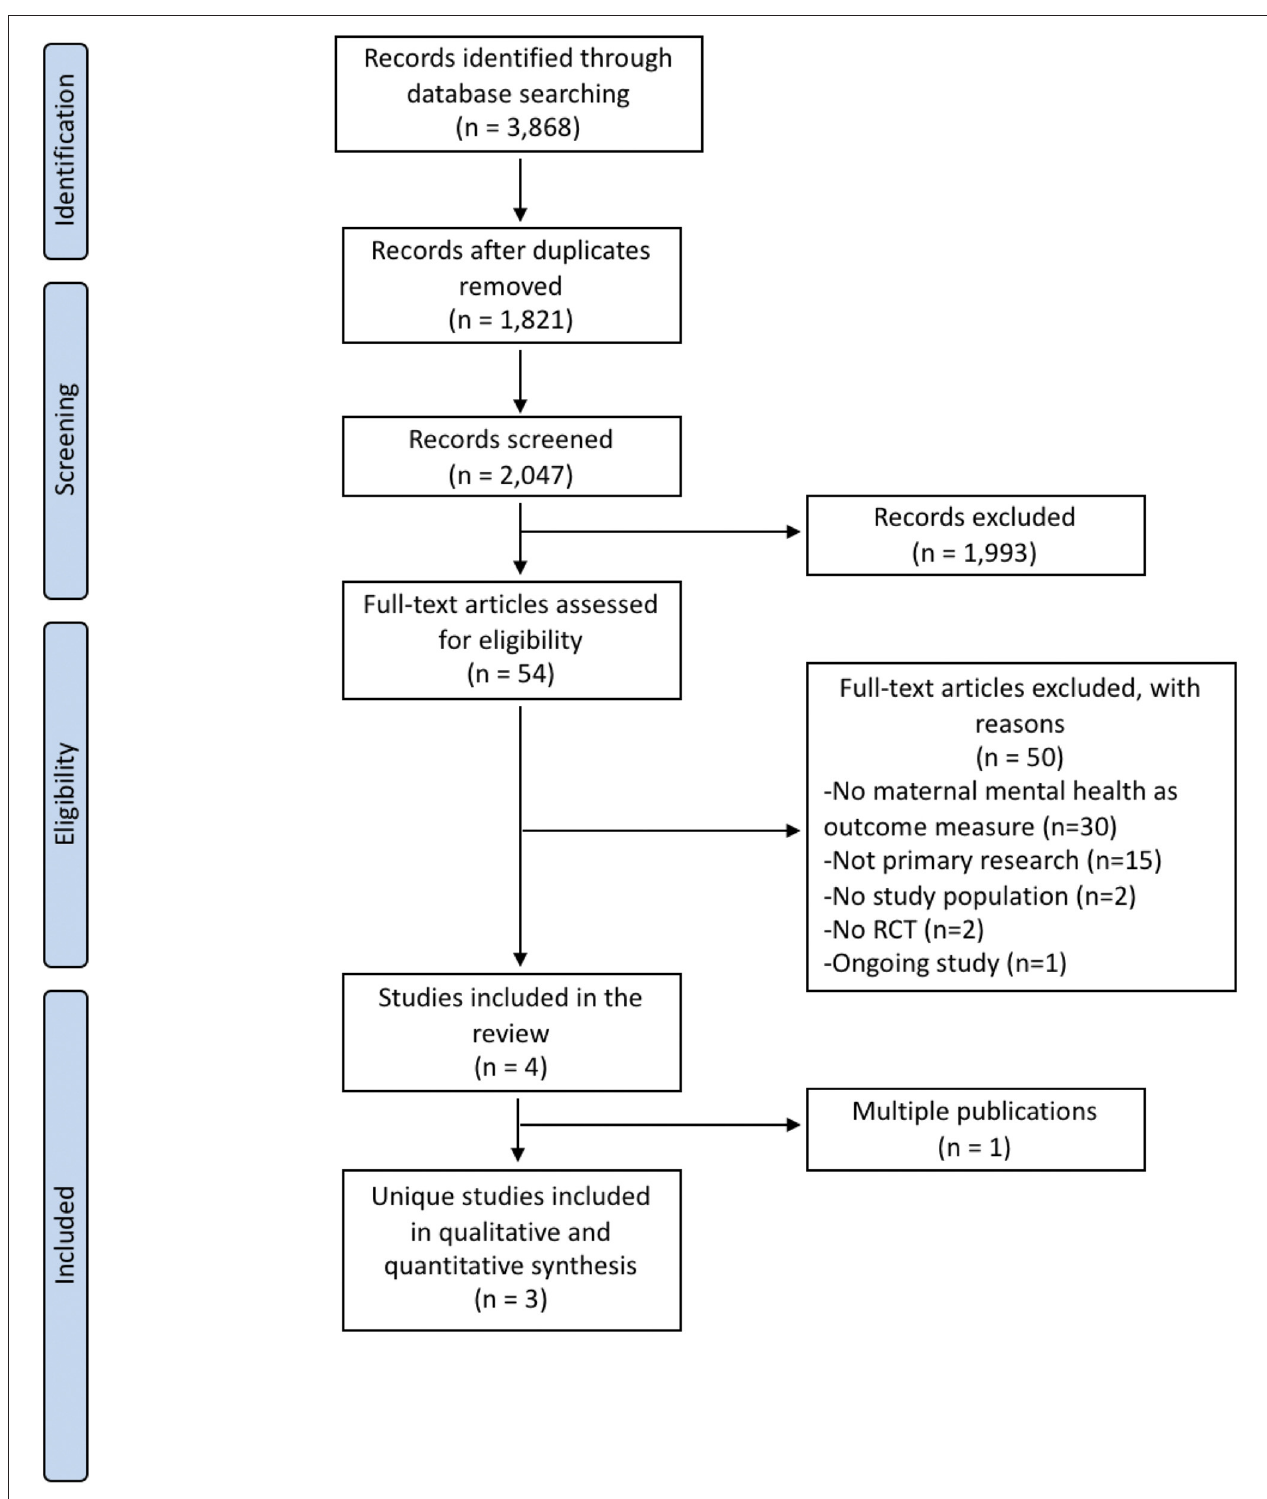
FIGURE 1 | PRISMA flow diagram of search strategy and study selection.